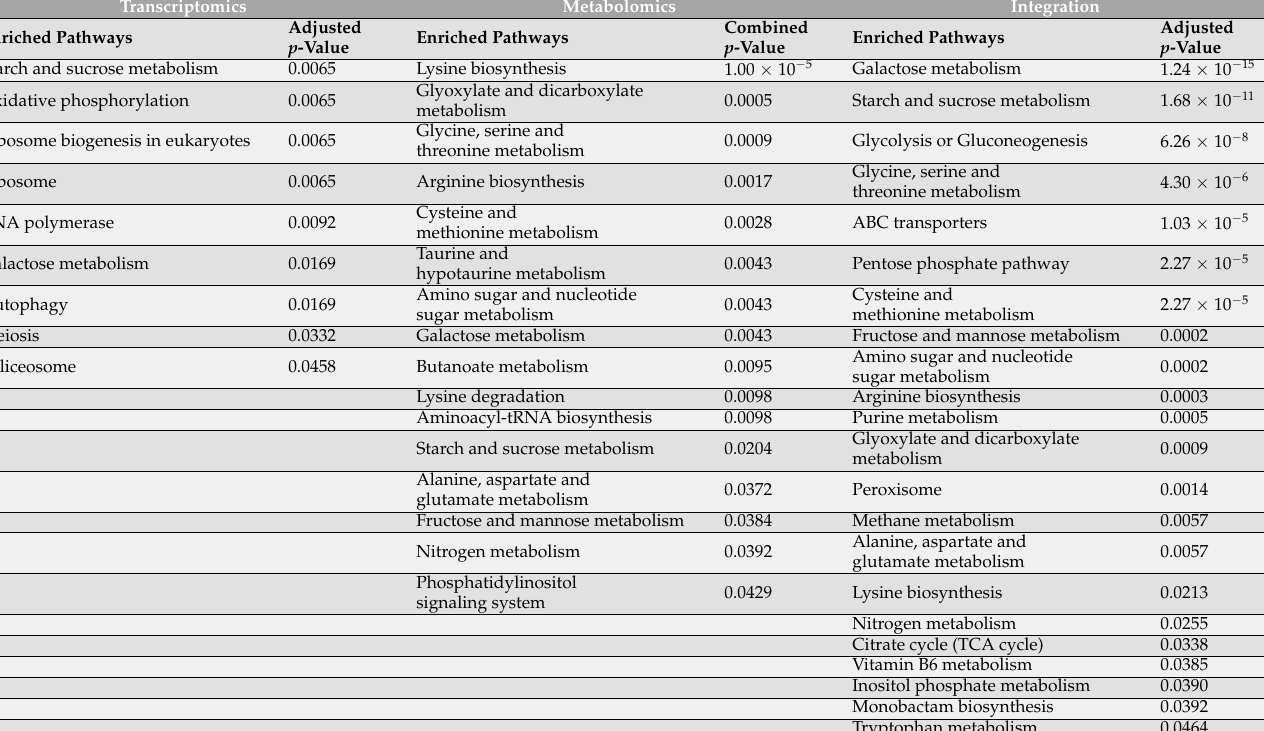
Table 4. Single- and multi-omics integration results for ras2 ∆ . First block shows GSEA for transcrip- tomics with adjusted p -value < 0.05, arranged in ascending order; second block shows MetaboAn- alystR pathway enrichment analysis for metabolomics with combined p -value < 0.05, arranged in ascending order; third block shows MetaboAnalystR joint pathway analysis with adjusted p -value < 0.05, arranged in ascending order, as detailed in